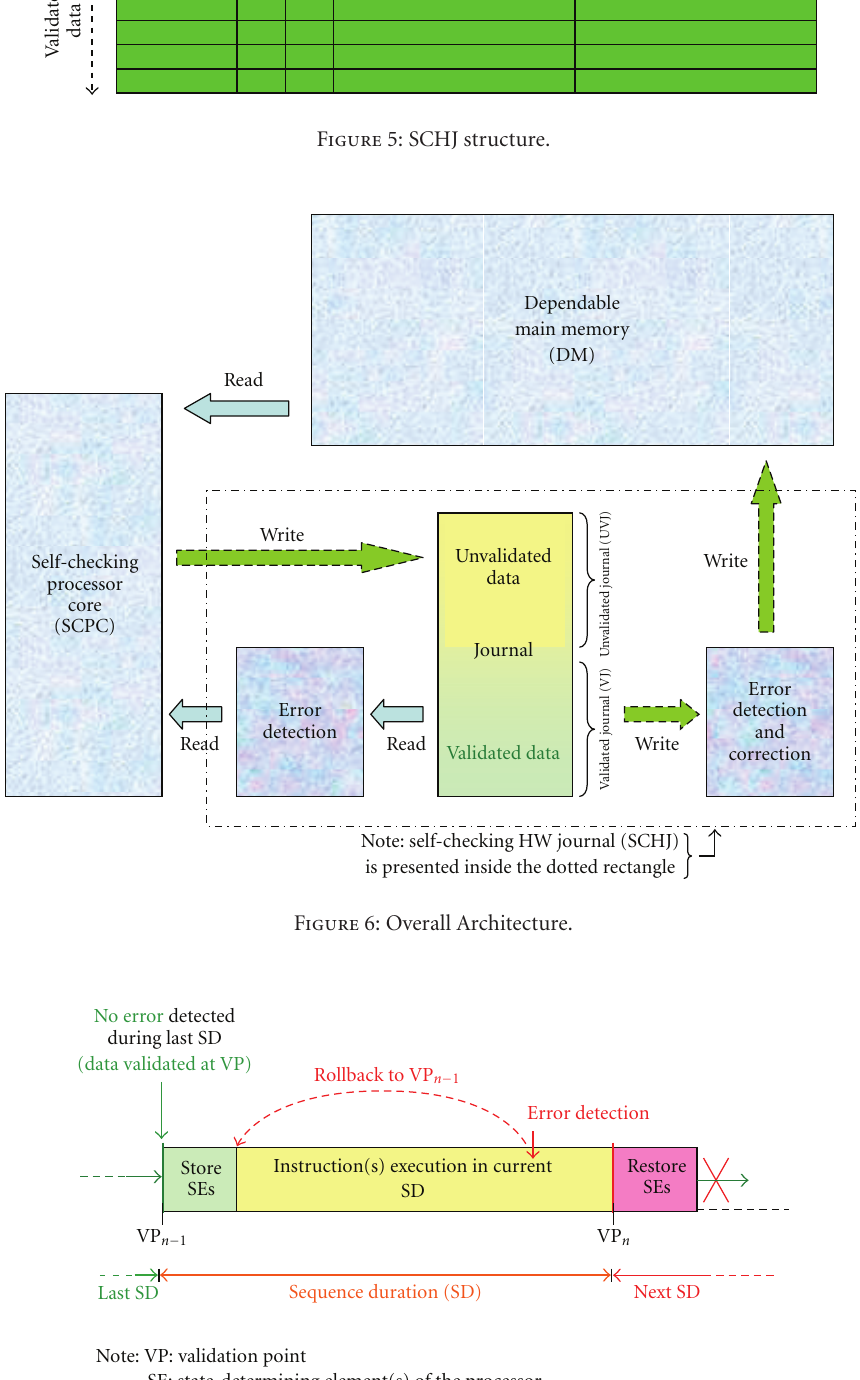
Figure 7: Rollback mechanism on error